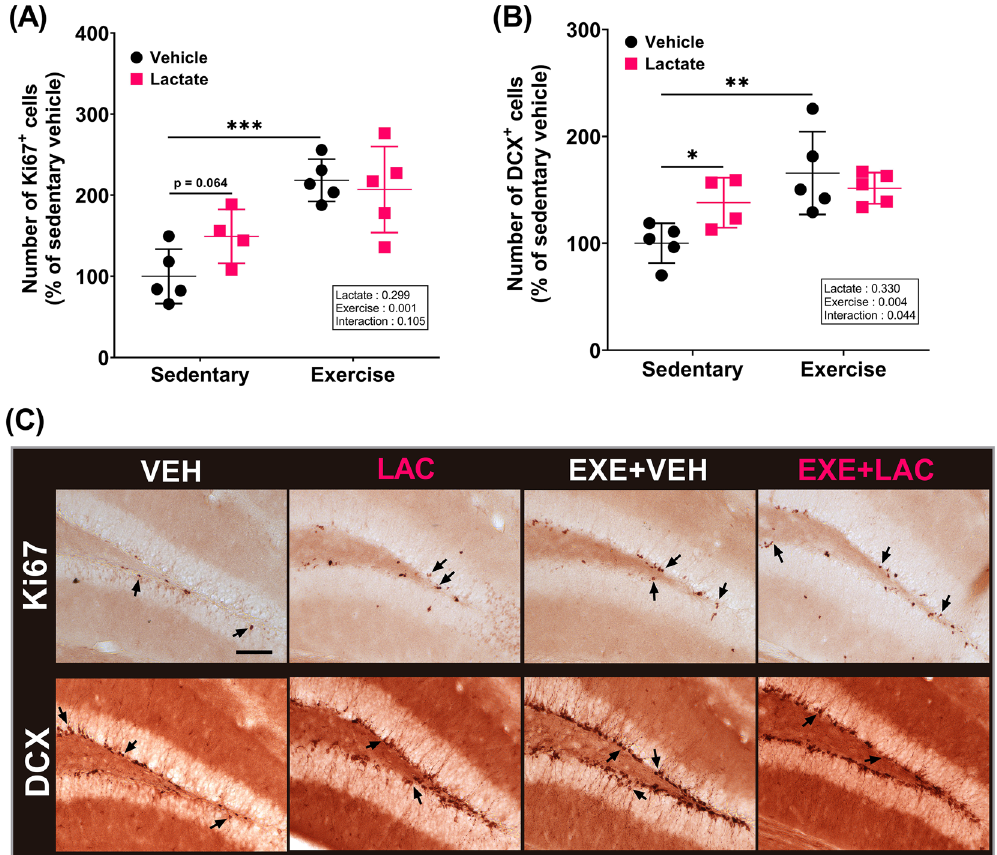
Figure 3. Exercise with lactate administration did not augment exercise-induced adult hippocampal neurogenesis, but lactate administration promoted adult hippocampal neurogenesis. ( A ) Quantification of Ki67-positive cell and ( B ) of DCX-positive cell in subgranular zone of dentate gyrus of mice. ( C ) The represent image of immunohistochemistry. Arrow indicates a represent positive cell. Scale bar: 100 μm. Two-way ANOVA was performed, and independent Student’s t -test was used for post hoc test ( n = 4–5 per group). VEH sedentary without lactate, LAC sedentary with lactate, EXE + VEH exercise without lactate, EXE + LAC exercise with lactate; * p < 0.05, ** p < 0.01, and *** p ≤ 0.005. Data are presented as the mean ± standard